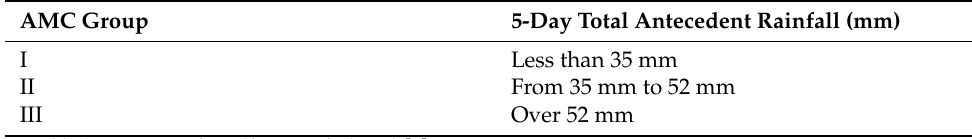
Table 1. Classification of antecedent moisture classes (AMC) for the soil conservation service (SCS) rainfall abstractions